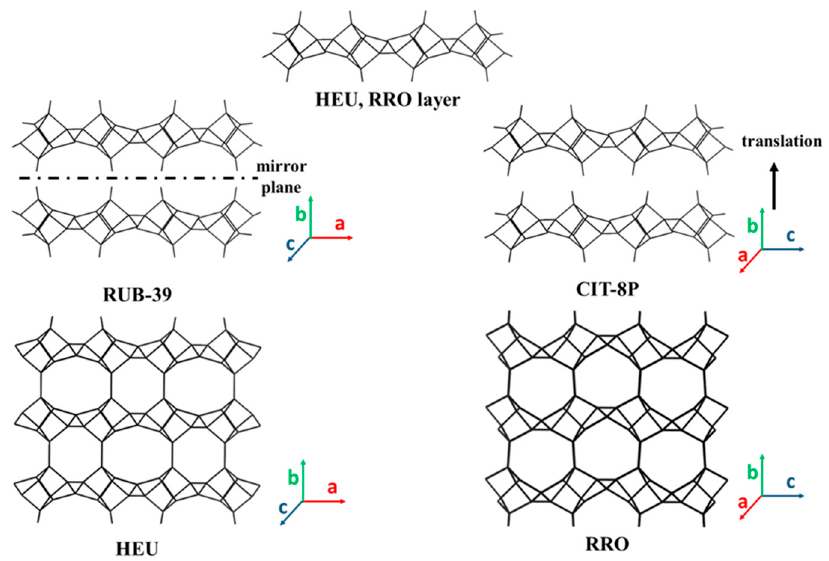
Figure 8. Schematic illustration of structures of 2D layered RUB-39 and CIT ((California Institute of Technology))-8P, and the corresponding 3D HEU and RRO zeolites.